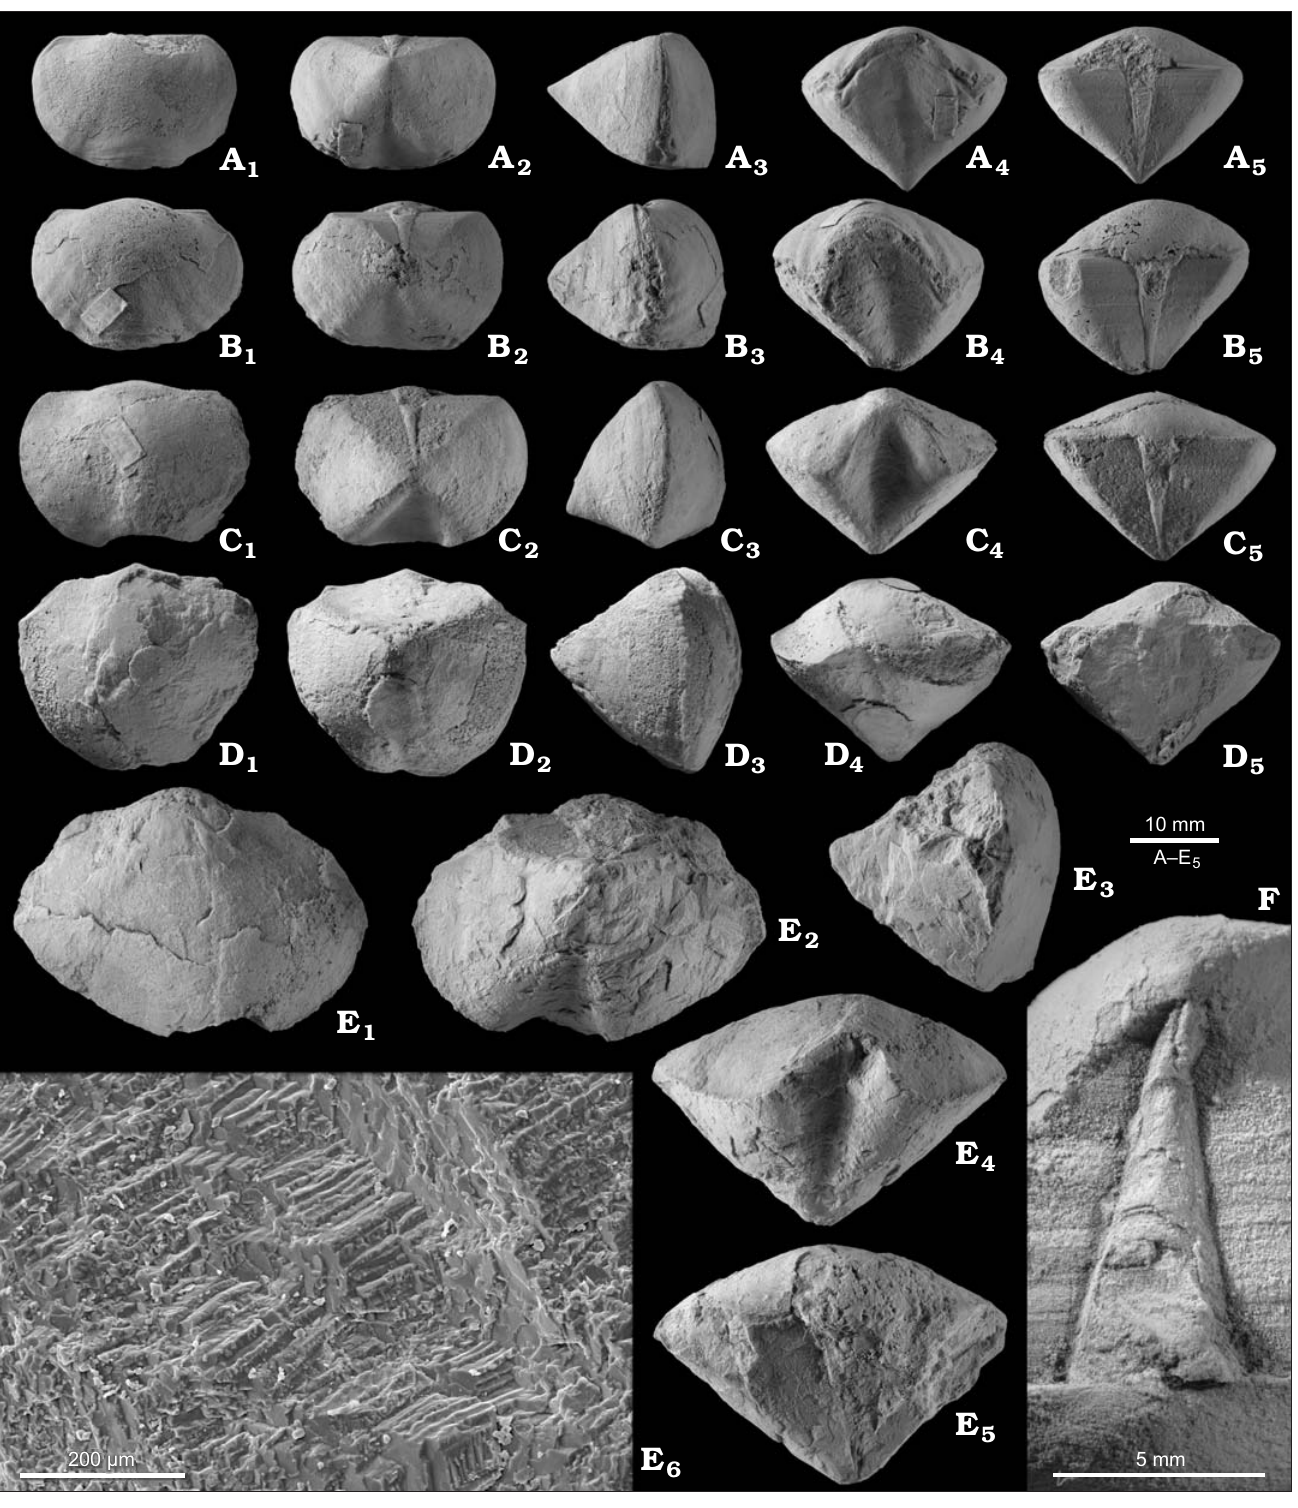
Fig. 2. Spiriferide brachiopod Thomasaria simplex (Phillips, 1841) from the Middle Devonian of south-western England, UK (type region). A – C . Articulated shells (TCD 16991c, A ; TCD 16991b, B ; TCD 16991a, C ) from Port Stephens, in dorsal (A 1 –C 1 ), ventral (A 2 –C 2 ), lateral (A 3 –C 3 ), anterior (A 4 –C 4 ), and posterior (A 5 –C 5 ) views. D . Lectotype, articulated shell GSM 6915 from Wolborough, in dorsal (D 1 ), ventral (D 2 ), lateral (D 3 ), anterior (D 4 ), and posterior (D 5 ) views. Reproduced with the permission of the British Geological Survey ©UKRI. All rights reserved. E . Topotype, articulated shell NHMUK PI B 2807 (specimen serially sectioned, see Fig. 3) from Wolborough, in dorsal (E 1 ), ventral (E 2 ), lateral (E 3 ), anterior (E 4 ), and posterior (E 5 ) views, enlarge- ment (SEM micrograph) of the secondary shell layer showing impunctate condition (E 6 ). F . Articulated shell TCD 16991d from Port Stephens, fragmentary posterior view showing the delthyrium partially closed by a convex